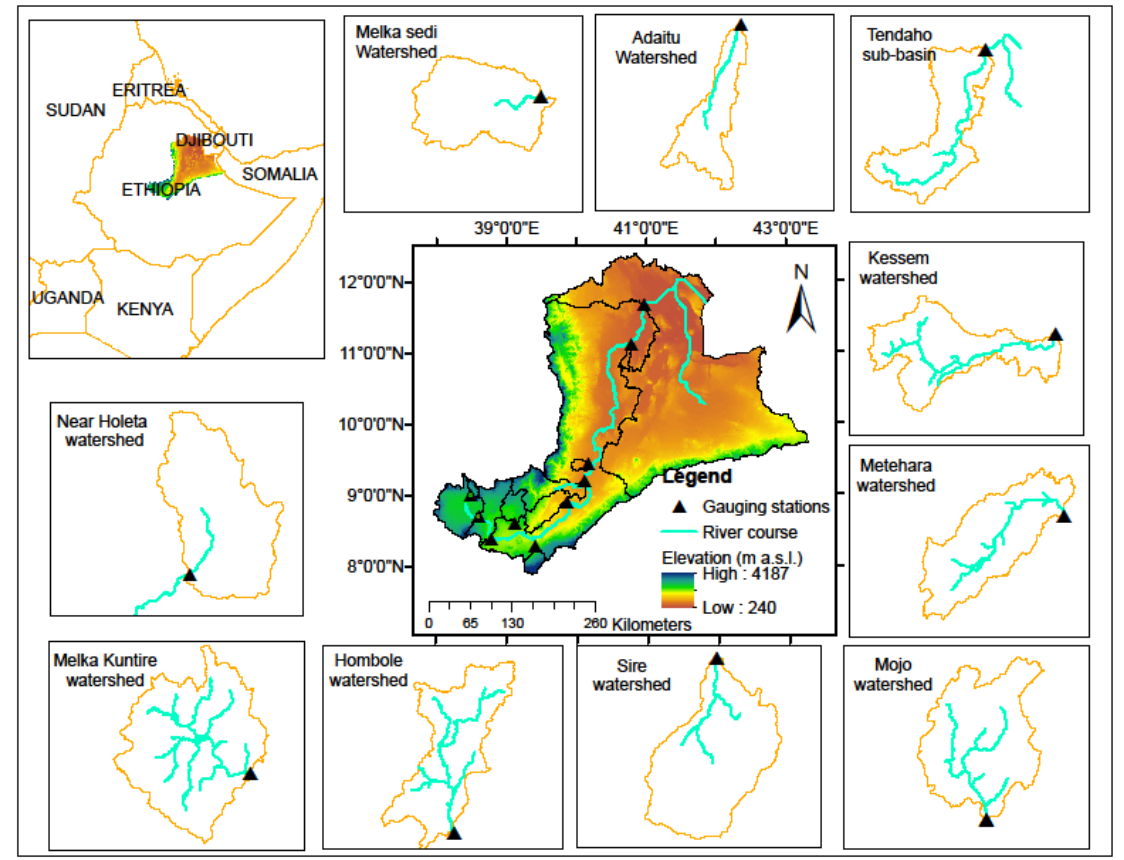
Figure 1. Gauging stations, elevation, and stream networks of the Awash River Basin (ARB) in Ethiopia. The average annual rainfall of the ARB varies from 160 (in Asaita of the Lower plain sub-basin) to 1600 mm at Ankober (the Western highland sub-basin). Additionally, mean annual temperature of the ARB ranges from 20.8 to 29 ◦ C at Koka (in the Upland sub-basin) and Dubti (in the Lower valley sub-basin), respectively [42]. The major land use land cover proportionate of the basin includes agricultural land (51.39%), grassland (29.79%), and shrublands (8.11%), respectively [40]. A climatic data summary of the ARB is provided in Table